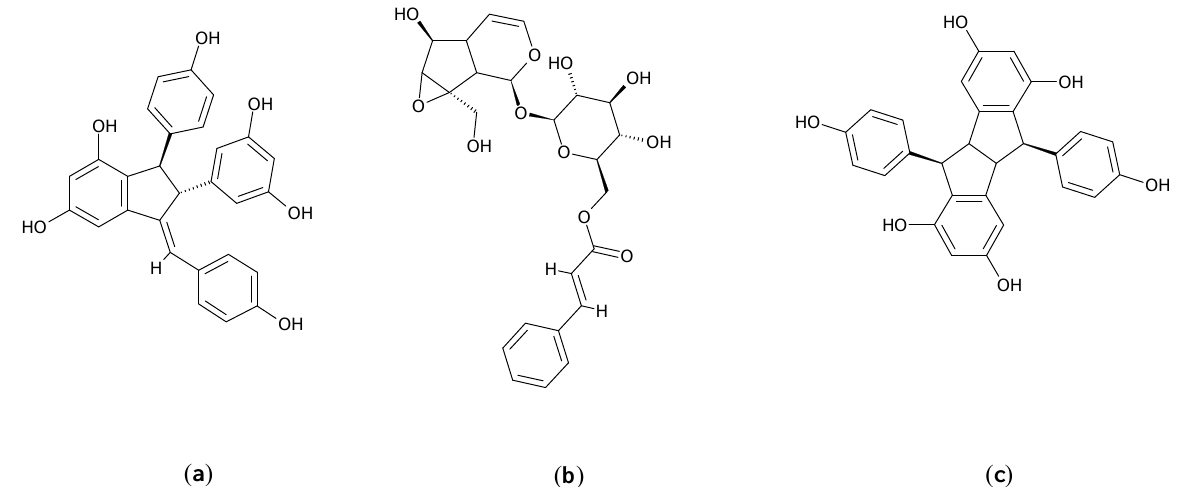
Figure 2. Bioactive phytochemicals of Cissus quadrangularis L.: ( a ) quadrangularin A (a stilbene dimer arising from resveratrol); ( b ) picroside I (an iridoid glycoside); ( c ) pallidol (a dimer of the stilbene